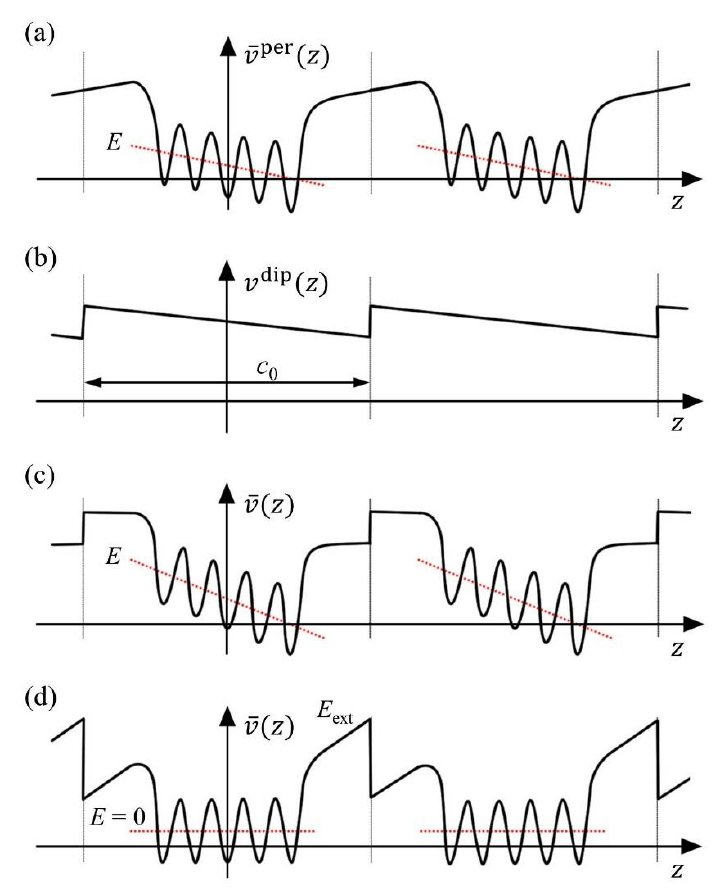
Figure 3. Schematic picture of the planar-averaged potential v slabs: ( a ) With periodic boundary conditions; ( b ) potential of the dipole layer; ( c ) dipole-corrected slabs with vanishing external electric field; and ( d ) dipole-corrected slabs with vanishing internal electric field. (Reproduced with permission from [164]; Copyright 2001 by the American Physical